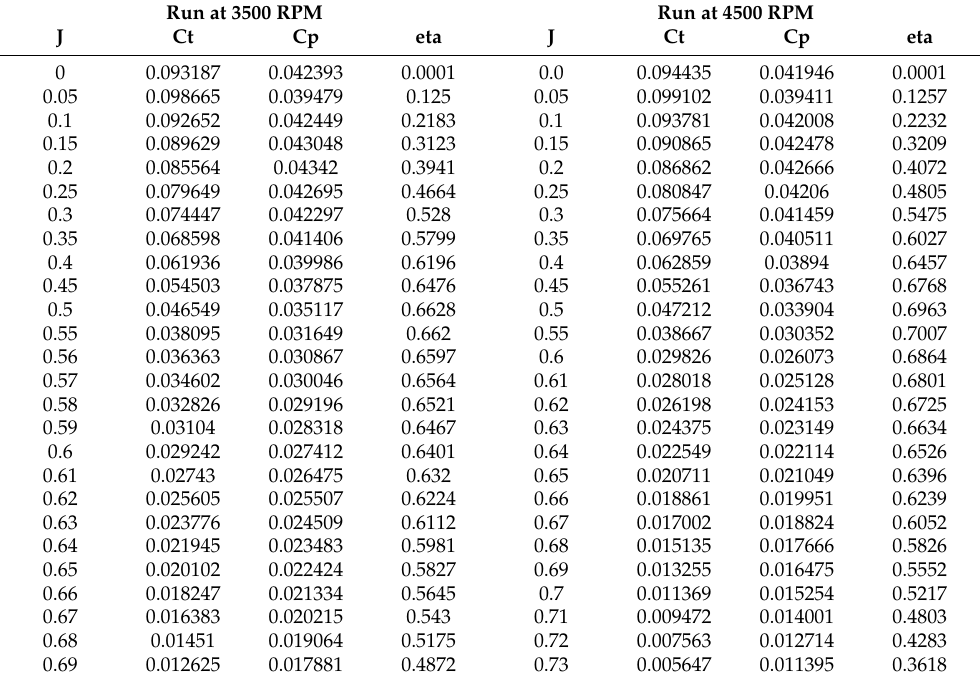
Table A26. BEMT 18 × 12 APC propeller